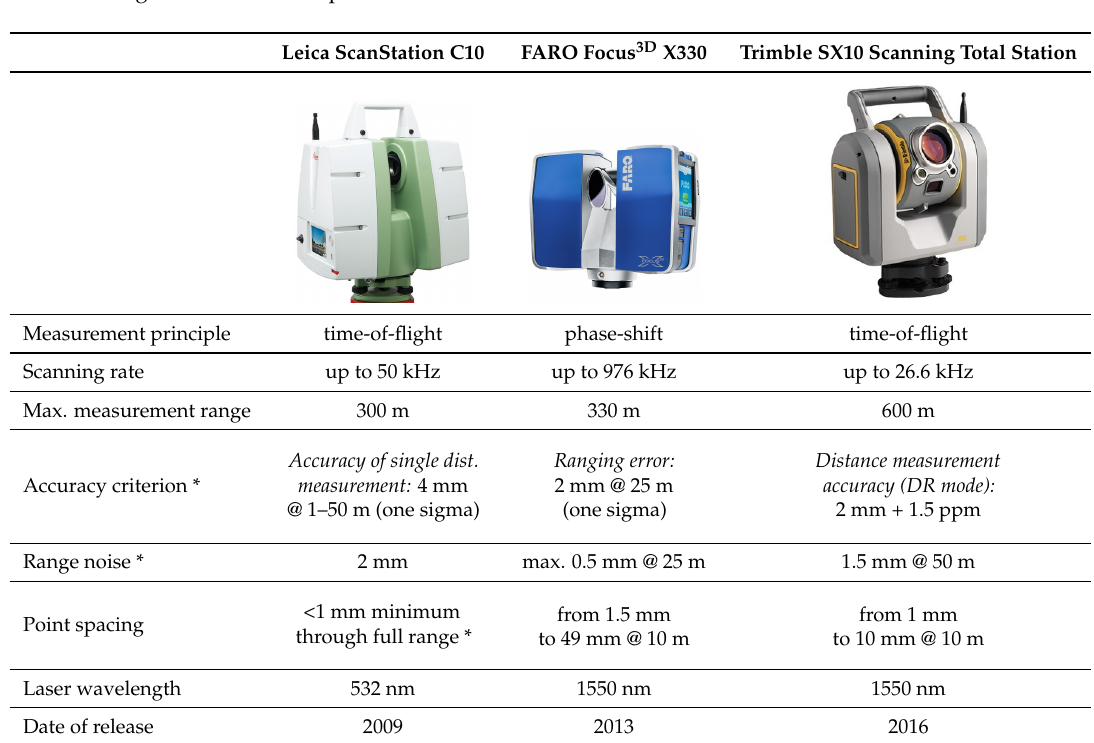
Table 4. Comparison of some technical properties of the three scanning devices used in the article, according to manufacturer